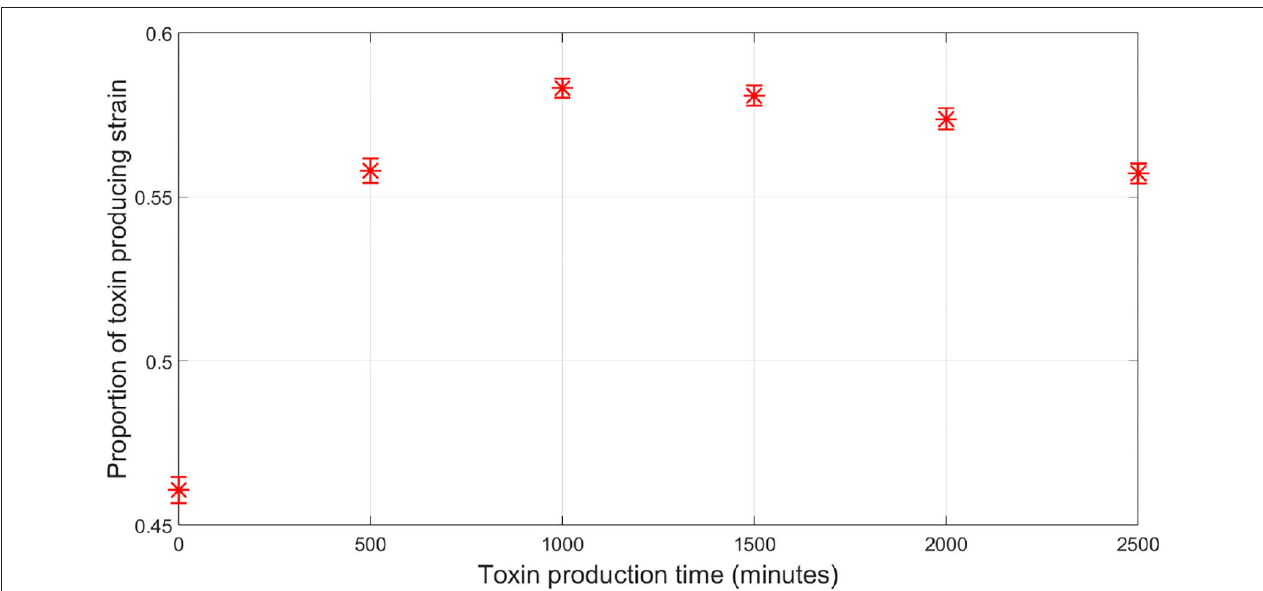
FIGURE 7 | The relationship between the time at which toxin production starts by the QS toxin producing strain and its fitness when competing with the sensitive strain, where the fitness of a given strain is defined as the proportion of the said strain in the population by the end of the simulation, in case of spatial competition in a biofilm. Time zero corresponds to constitutive toxin